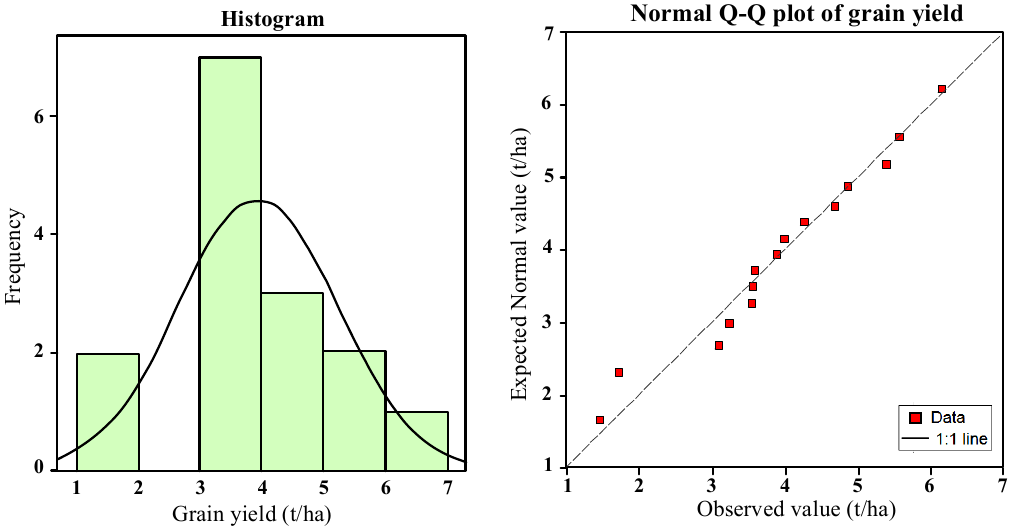
Figure 3. Histogram of the grain yields distribution and Q-Q plot.